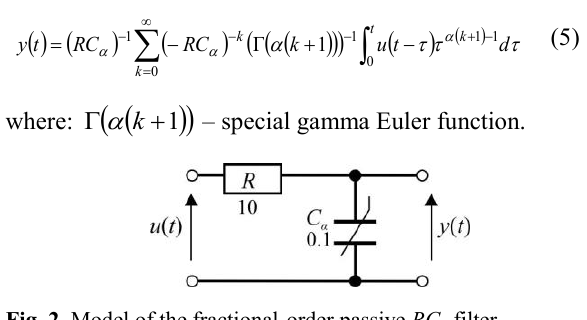
Fig. 2. Model of the fractional-order passive RC α filter.